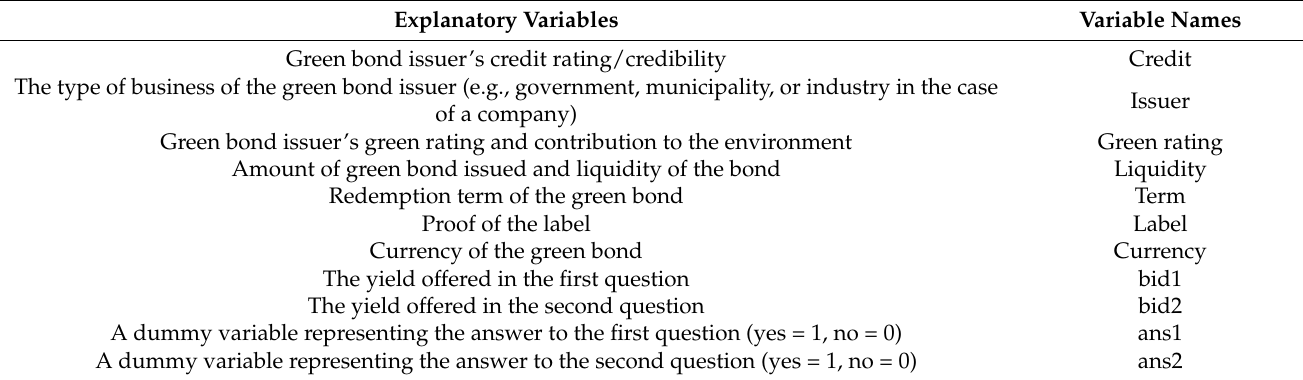
Table 1. Explanatory variables and variable